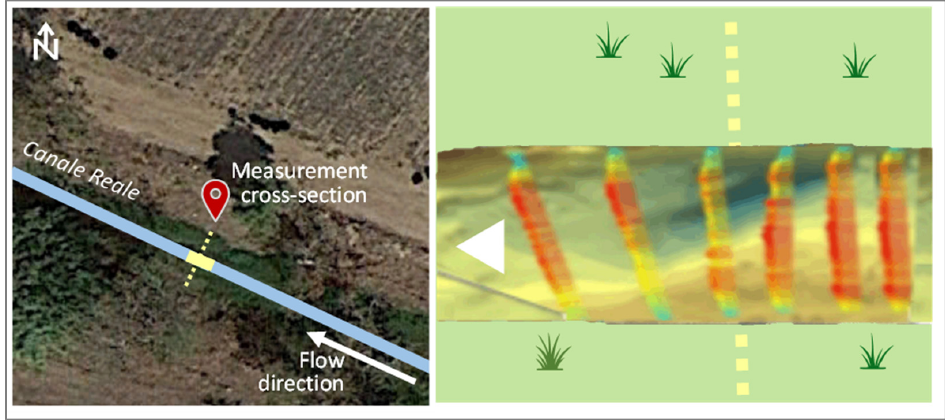
Figure 13. Detection of different layers and waves of the channel vs. depth for cross-section B2.